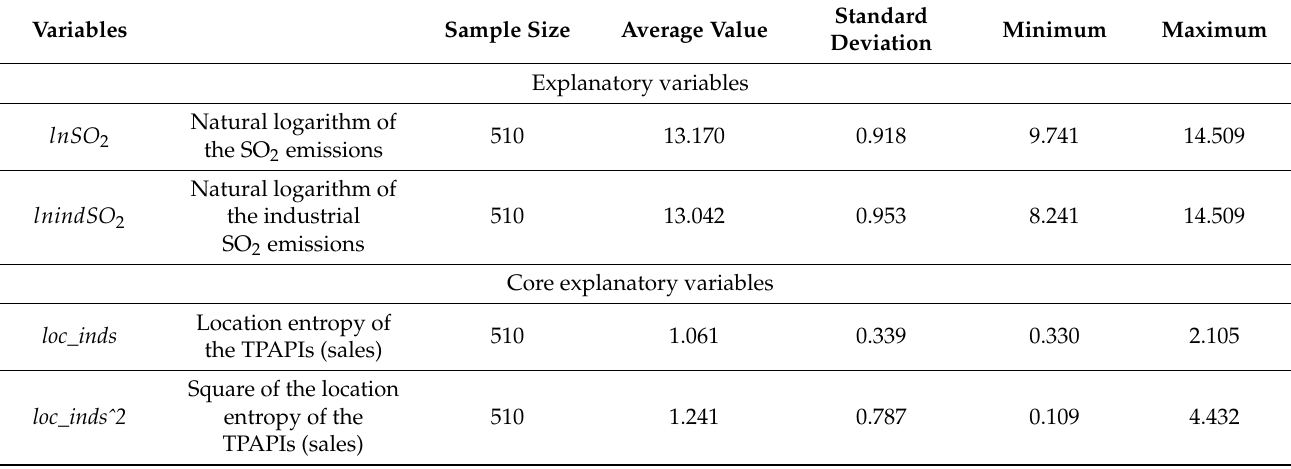
Table 2. Model Variable Selection and Descriptive